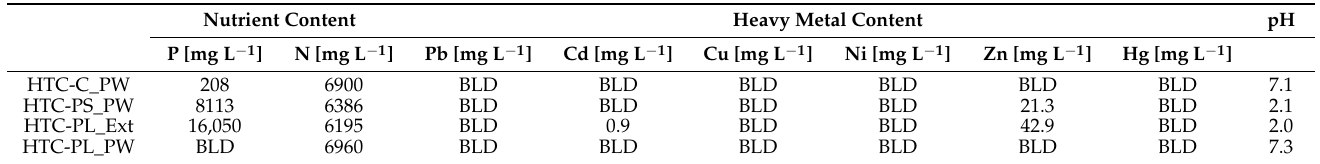
Table 3. Content analysis of process water (PW) and leaching extract (Ext). (C = Control; PS = P stripping; PL = P leaching; BLD = bellow limit of detection) ( n =